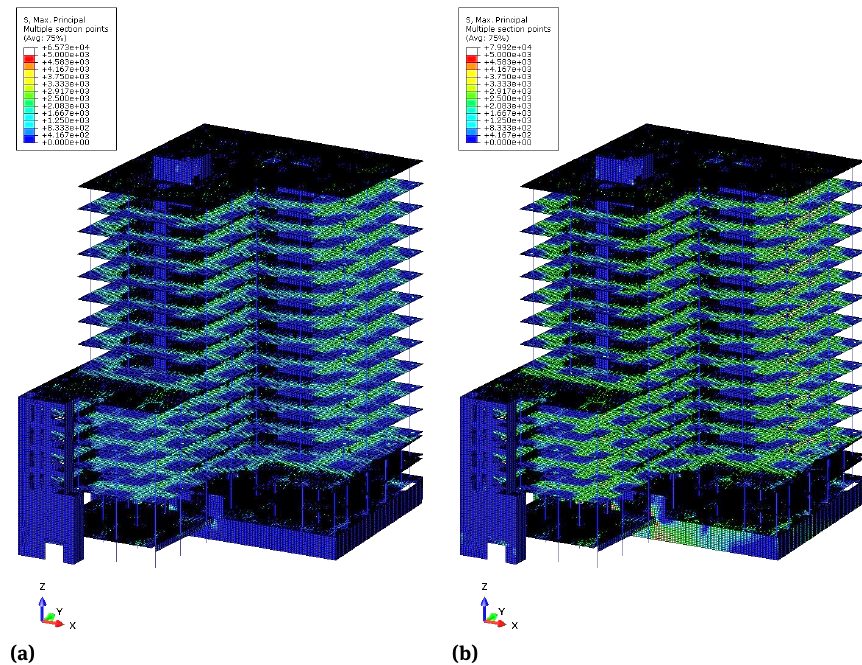
Figure 10: Maximum principal stress [kPa]: a) in model with rigid support, b) in model with subsoil defined by elastico-plastic Cam Clay